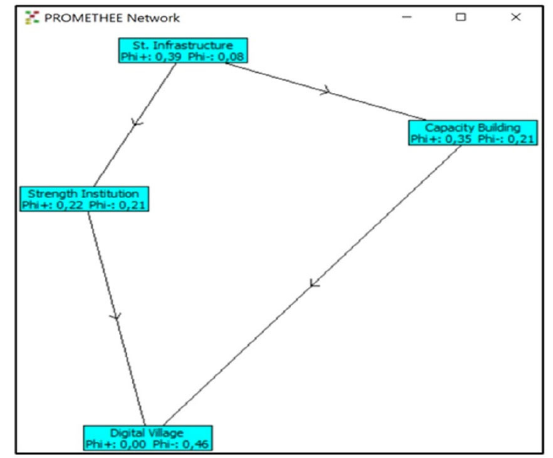
Fig. 5. Tourism Village Development Strategy